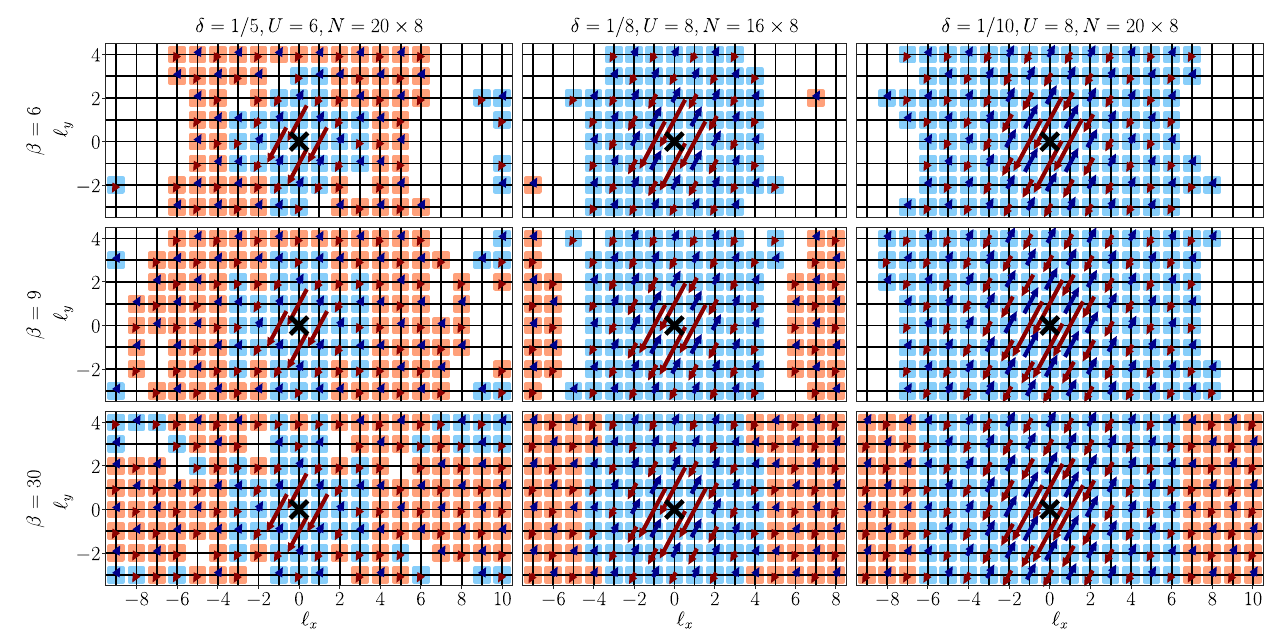
FIG. 2. Evolution of the spin correlation function C s ð l x ; l y Þ as T is lowered ( T ¼ 1 = 6 , 1 = 9 , and 1 = 30 from top to bottom), for doping δ ¼ 1 = 5 , U ¼ 6 (left column), δ ¼ 1 = 8 , U ¼ 8 (middle), and δ ¼ 1 = 10 , U ¼ 8 (right). These are obtained from our first type of calculations, using fully periodic supercells along both directions, with the correlation averaged over all reference sites i , indicated by the black cross. [The amplitude of C s ð 0 ; 0 Þ is not shown.] The color of the arrows indicates the sign (dark blue, þ ; purple, − ), while the length of the arrows is proportional to the amplitude of C s ð l x ; l y Þ . The color of the square at each site represents the sign of the staggered spin correlation ð − 1 Þ l x þ l y C s ð l x ; l y Þ . A missing arrow and missing colored square indicate that j C s ð l x ; l y Þj is less than twice its Monte Carlo error bar, which is considered approximately zero within our statistical